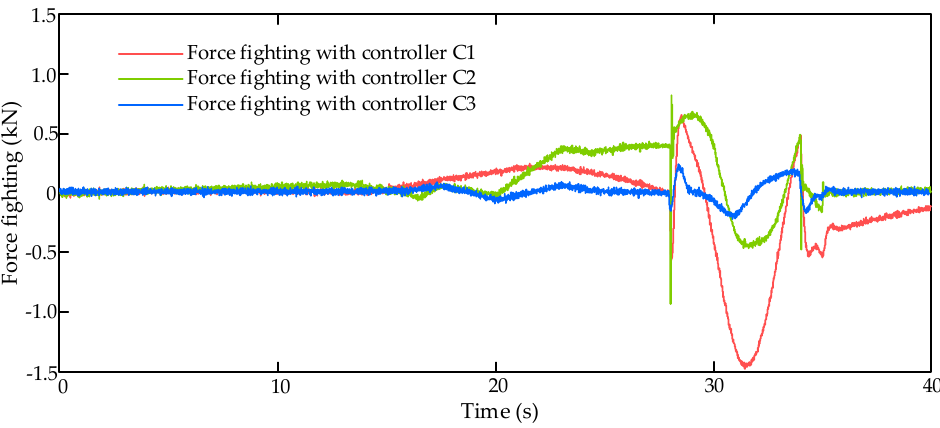
Figure 11. Force fighting results with real flight control command under random perturbance.